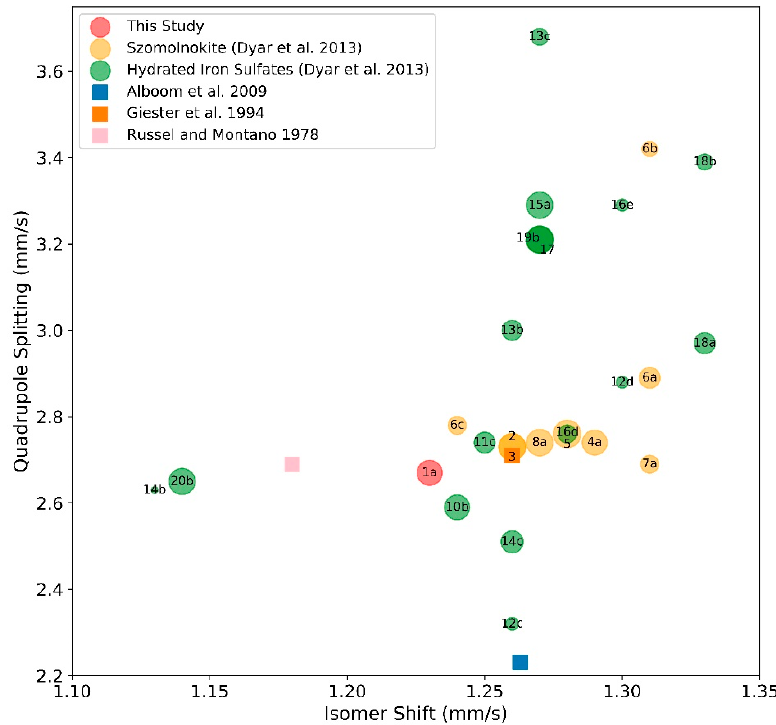
Figure 2. Isomer shift relative to bcc-iron versus quadrupole splitting at 0 GPa of 57 Fe-Mössbauer sites in a variety of hydrated iron sulfates. Circles with the same number represent different sites within a single sample. Labels come from [12–14,22] (see Table S5). Size of circle represents weight fraction of that site. The colored squares represent values from earlier Mössbauer studies of szomolnokite. The IS of site 1b from this study is out of the range of this figure at 0.89 ± 0.02 mm/s.